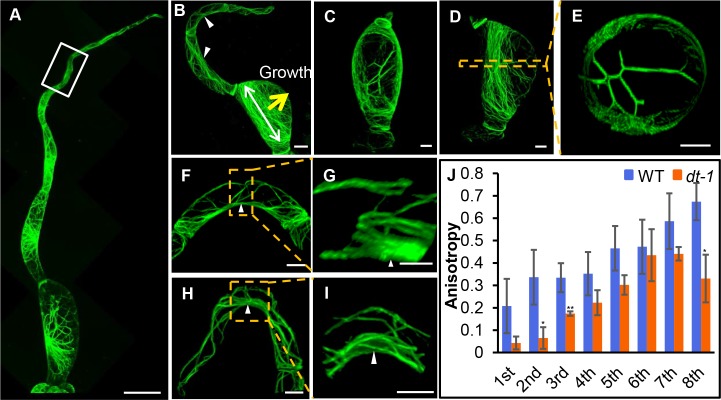
Visualization of actin organization in type II trichomes in dt-1 mutant.(A) Overall view of actin organization in type II trichomes in dt-1 mutant. Most of actin filaments orientated randomly. Bar: 20 μm. (B) Overall view of actin organization in type III trichomes in dt-1 mutant. The alignment of actin filaments derived from the swollen cell. The yellow arrow indicates the major swelling direction; white arrow shows the main orientation of actin filaments. White Triangles point to dense actin bundles. Bar: 20 μm. (C-E) Actin configuration in swollen trichome cells. (E) shows the cross section of the boxed region in (D). Bar: 20 μm. (F, G) Actin organization in the curved cell of the box of (A). Bar: 20 μm. (G) is the amplification of the boxed region in (F). White Triangles point to dense actin bundles. Bar: 10 μm. (H, I) Actin organization in the curved cell locating on the top of type II trichomes. Bar: 20 μm. (I) is the amplification of the boxed region in (H). Triangles point to dense actin bundles. Bar: 10 μm. (J) Quantitative analyses of the anisotropy of actin filaments by FibrilTool. Anisotropy values range from 0 to 1. 0 indicates pure isotropy, and 1 represents pure anisotropy. (*P<0.1 and**P<0.01).